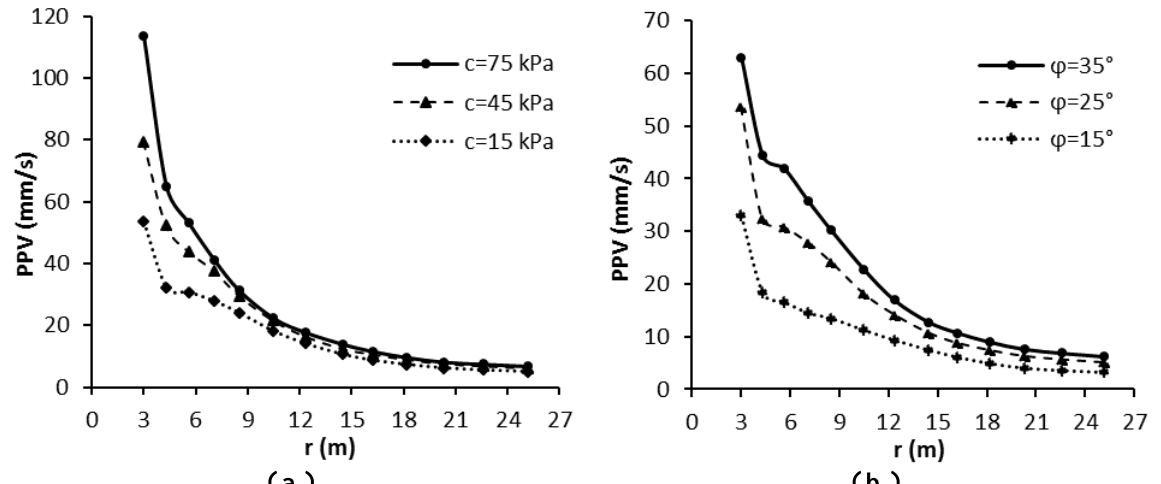
Fig. 12. Variation of PPV values on the ground surface with radial distance from pile axis for the impact force of 3.2 MN and various shear strength parameters of soil: a) cohesion b) friction